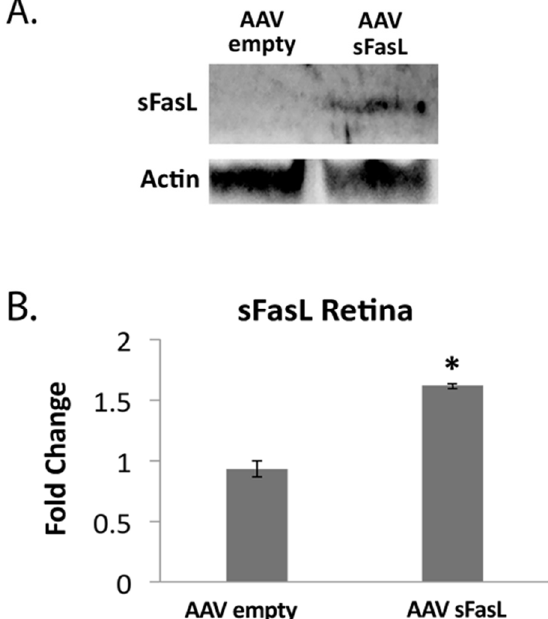
Figure 6. Measurable levels of sFasL are detected in the retina post IVT injection of AAV2-sFasL. Wild-type mice ( n = 5 per group) were given IVT AAV2-sFasL or IVT AAV2-empty vector in each eye. ( A ) After 10 days, protein from neurosensory retinas was extracted for Western blot analysis using anti-sFasL. β -Actin was used for normalization. ( B ) Graph shows increased sFasL in retinas of mice that received AAV2-sFasL relative to mice receiving AAV2 empty vector. * p < 0.05.